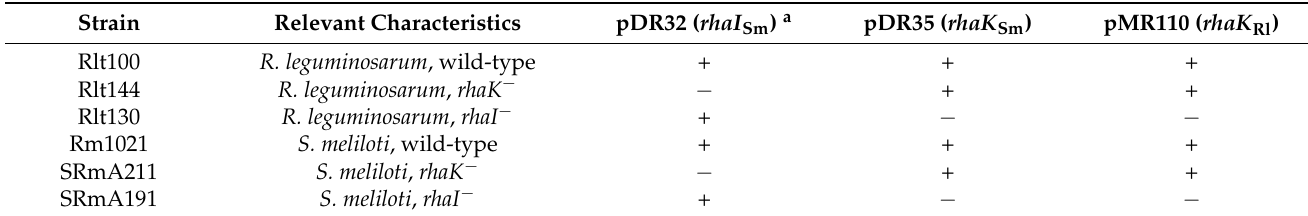
Table 3. Plasmid encoded rhaK and rhaI can heterologously complement corresponding mutations in both S. meliloti and R. leguminosarum .